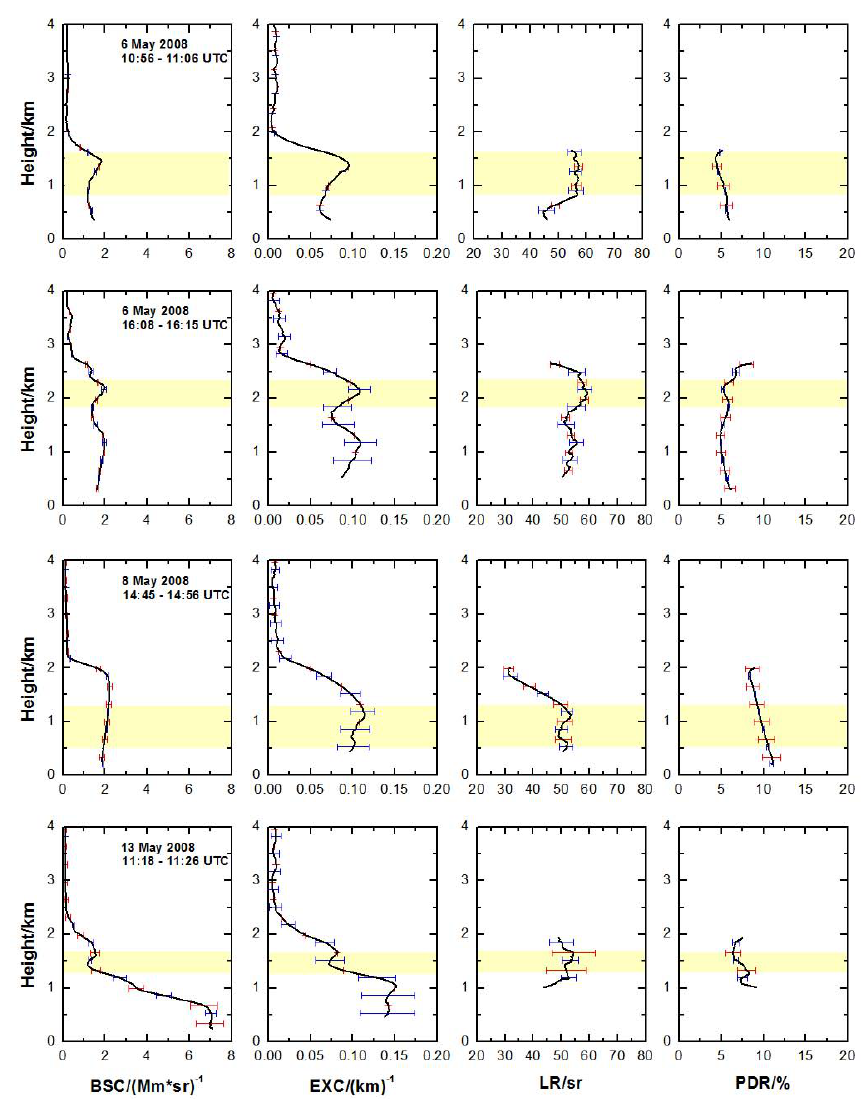
Fig. 7. Vertical profiles of backscatter coefficient (BSC), extinction coefficient (EXC), lidar ratio and particle linear depolarisation ratio (PDR) at 532nm for selected measurement periods during the first half of the EUCAARI-LONGREX campaign. The red error bars indicate the systematic errors; the blue error bars indicate the statistical errors. Height levels meeting the criteria for pollution influenced layers are indicated by the light